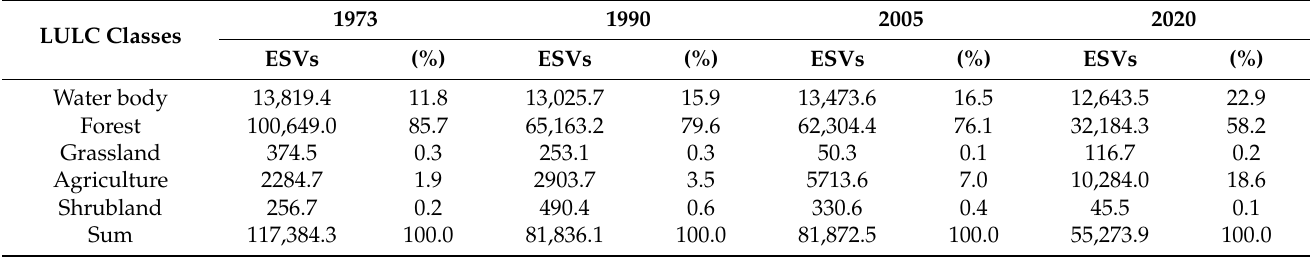
Table 8. Effects of LULC Changes on the total ecosystem service values (ESVs) (in millions of US $; 2020 price levels) in the Central Rift Valley lakes basin.